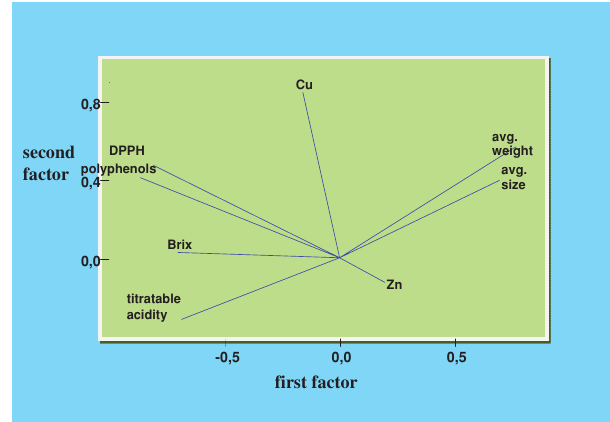
Figure 3: Principal component analysis, score plot of sour cherry